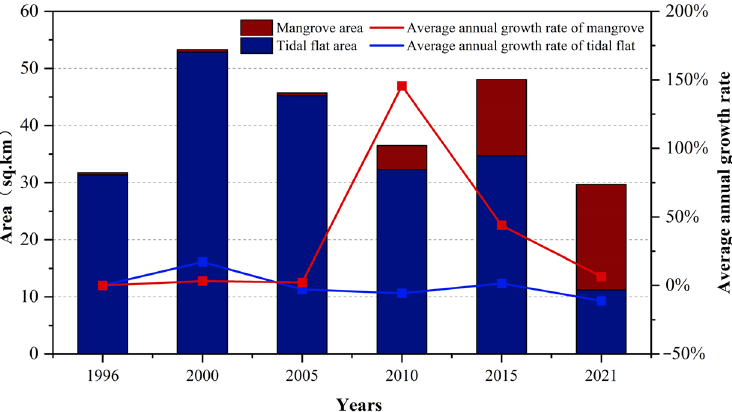
Figure 19. Map of land stock and annual growth rate in Maowei sea region from 1996 to 2021.